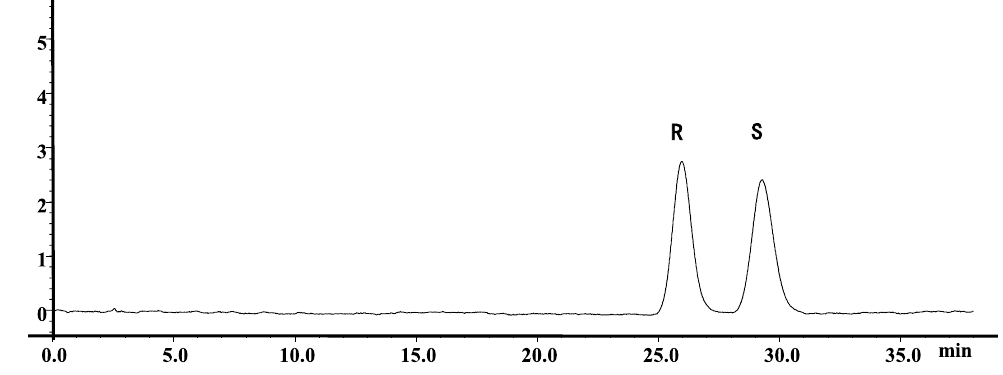
Figure 2. Chromatogram for the resolution of racemic HCQ. Chromatographic conditions: Chiralpak AD-H (4.6 mm × 150 mm, 5 μm particle size); n-hexane-isopropanol (93:7, v/v) plus 0.5% DEA into hexane as mobile phase at a flow rate of 0.8 ml/min with UV detection at 343 nm at 20 °C.